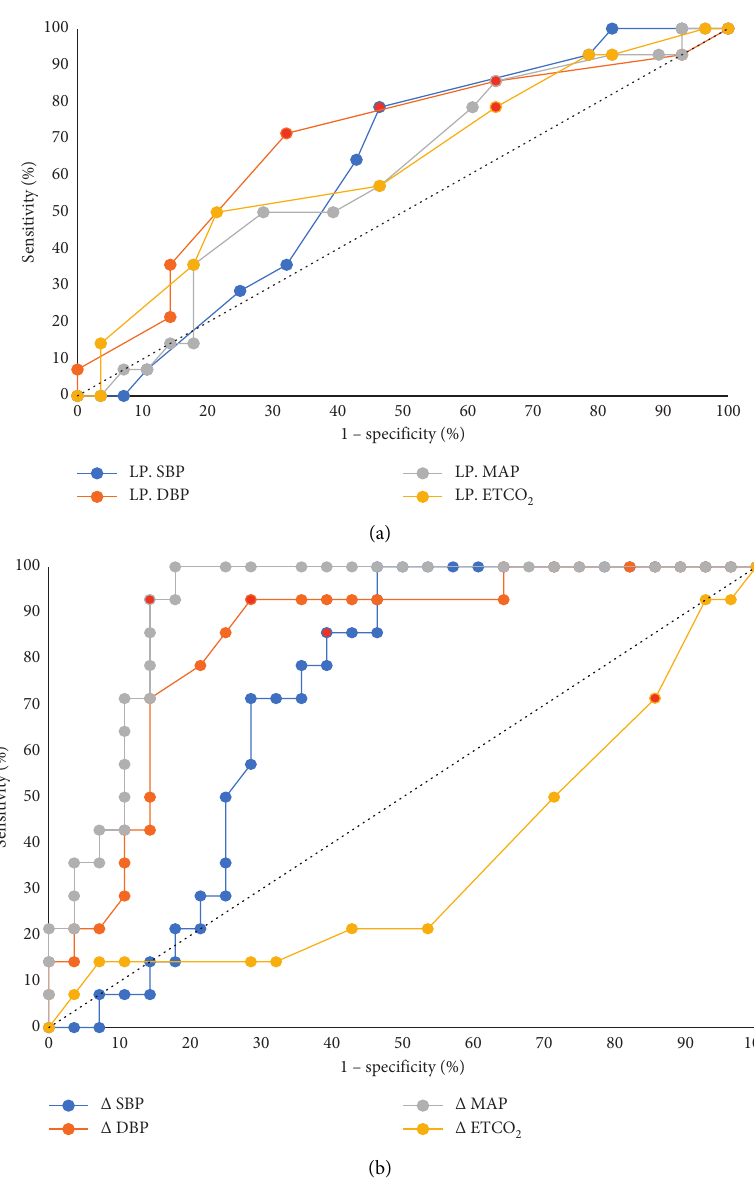
Figure 1: The ROC curve (a) presents the optimized cutoff point of mean of the lowest point of blood pressure and end-tidal carbon dioxide, whereas the optimized cutoff point of the mean difference between the lowest point and the baselined point at initial procedure is shown as the ROC curve. (b) The recommended optimal cutoff point of each line is presented with a red dot (LP, the lowest point; Δ , mean difference; SBP, systolic blood pressure; DBP, diastolic blood pressure; MAP, mean arterial blood pressure; ETCO 2 , end-tidal carbon